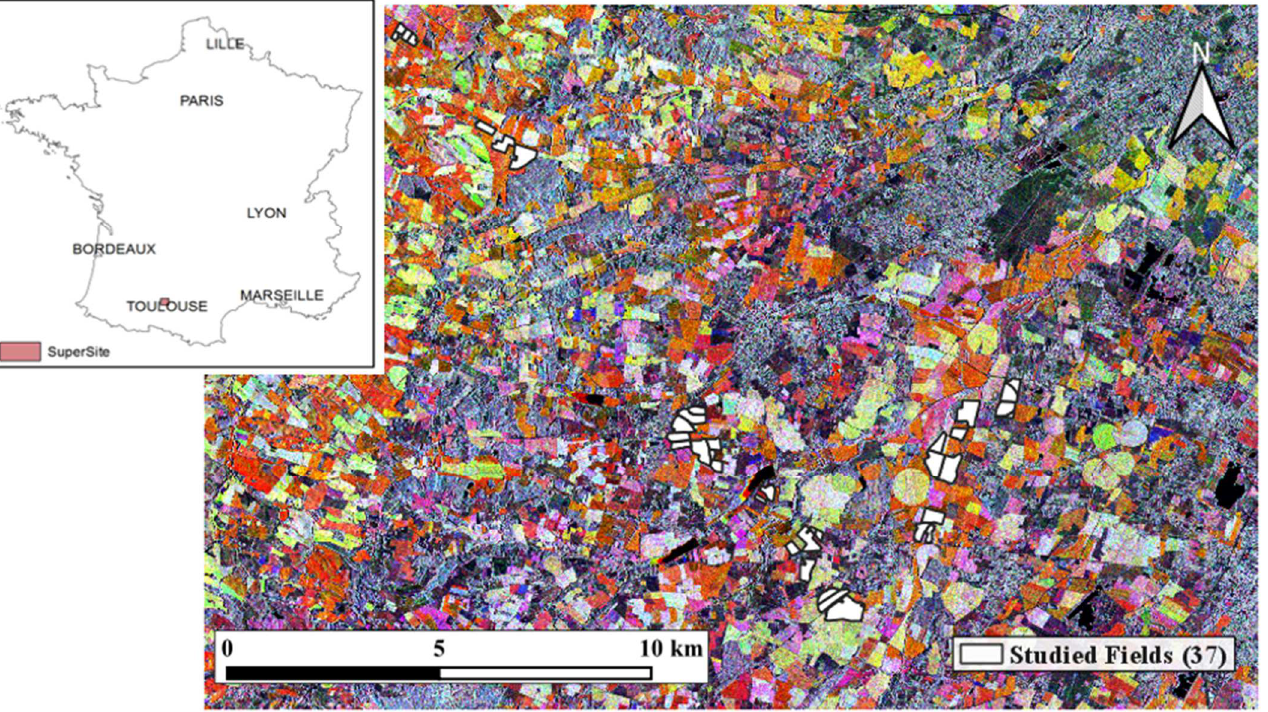
Figure 1. Location of the study site (super site) in southwestern France. The network of the 37 surveyed fields (white polygons) is superimposed on a color-composed TerraSAR-X image acquired in StripMap mode in HH polarization (red: 23 November 2010; green: 16 August 2010; blue: 20 May 2010).